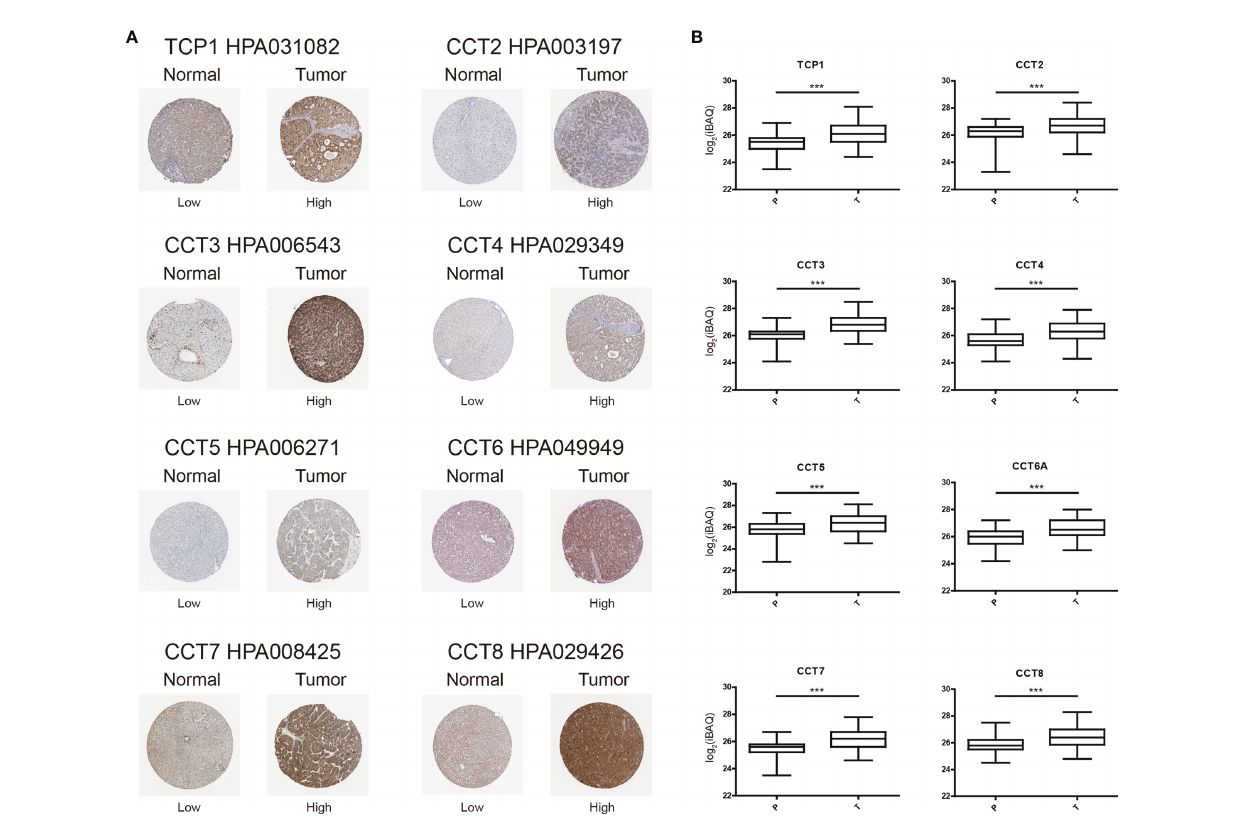
FIGURE 2 | Elevated expression levels of TRiC subunit proteins in HCC tissues versus normal tissues as evidenced by immunohistochemistry (from The Human Protein Atlas). (A) Representative images of tissues immunostained with the indicated HPA antibodies. (B) Mass spectrometry-based quantitative proteomics analysis. ***p <